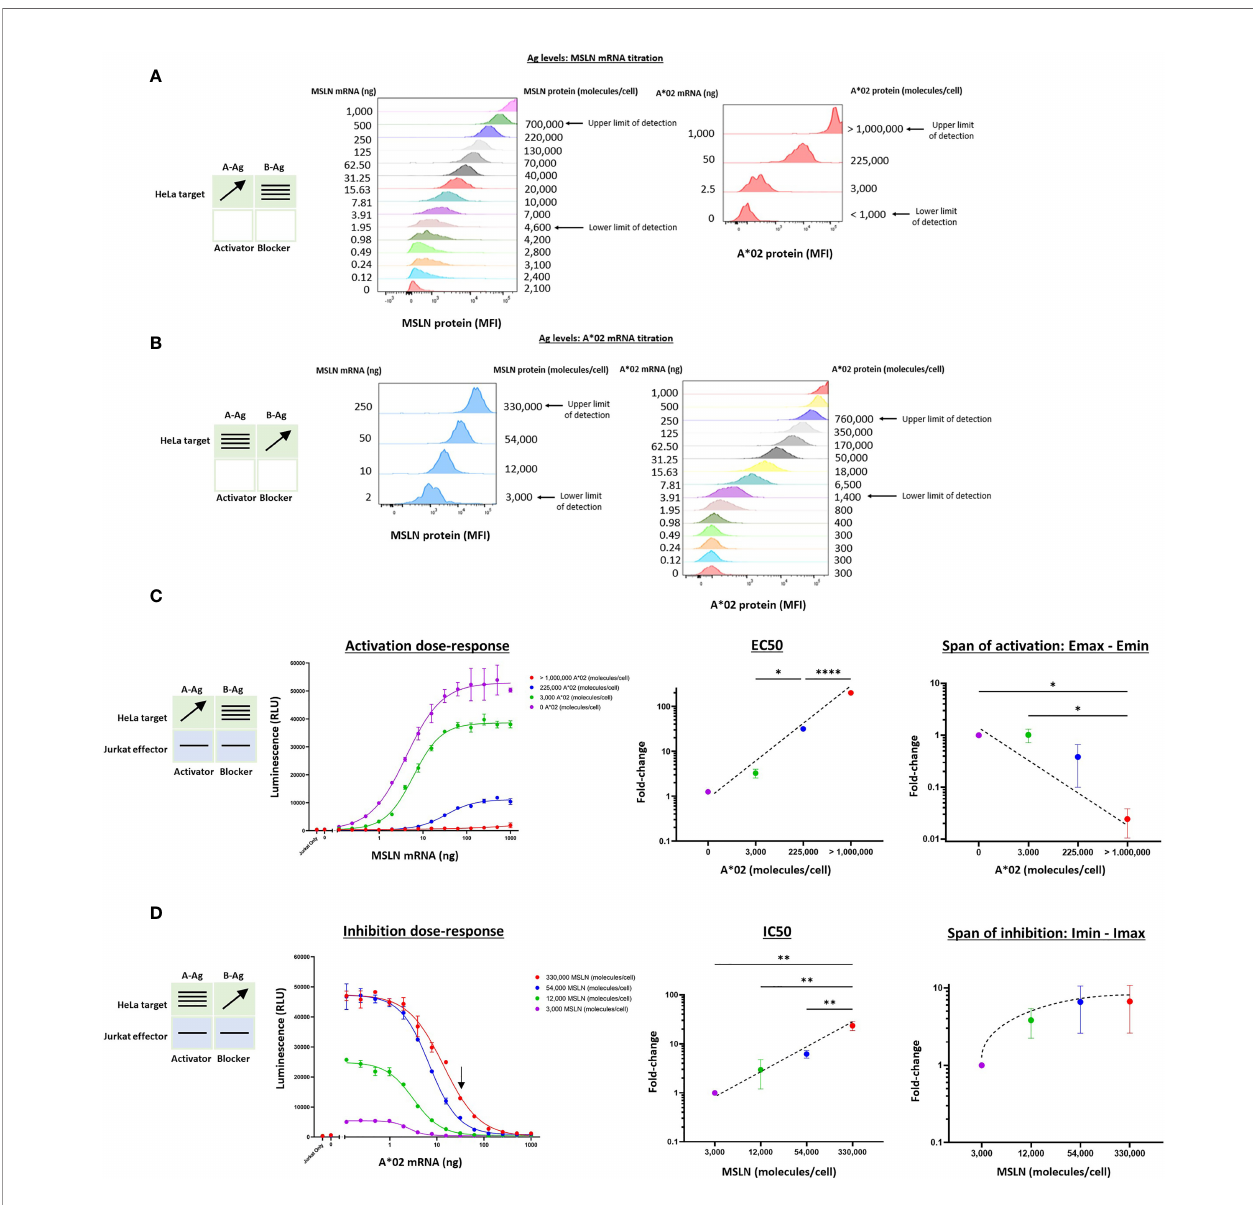
FIGURE 2 | Two-dimensional target Ag (MSLN and A*02) mRNA titration in HeLa [A*02(-)MSLN(-)] target cells. Target cells were a HeLa variant with MSLN knocked out (see Methods ). (A) MSLN (A-Ag) titration and surface expression visualized by fl ow cytometry. (B) A*02 (B-Ag) titration. The lower and upper limits of detection are shown. These de fi ne the observable boundaries of Ag inputs explored in the assay. See Methods for staining reagents, and Supplementary Figure 1 for standard curves that relate mRNA level to molecules/cell. (C) Dose-response of MSLN and A*02 target Ag variation with constant activator/blocker ratio on effector cells. MSLN A-Ag titrated with varying A*02 B-Ag levels held constant (EC50 and Emax vs B-Ag levels). For the red curve (>1,000,000 A*02 molecules/cell), the EC50 was estimated to be the maximum MSLN Ag tested, since the curve did not increase or plateau and curve- fi tting was inaccurate. Fold-change is calculated by normalizing to the lowest B-Ag value. (D) A*02 B-Ag titrated with varying MSLN A-Ag levels held constant (IC50 and Imax vs. A-Ag levels). Fold-change is calculated by normalizing to the lowest A-Ag value. Dashed lines are meant to convey trends and are not fi t mathematically. *p<0.05, **p < 0.01, ***p < 0.001, ****p < 0.0001, n =